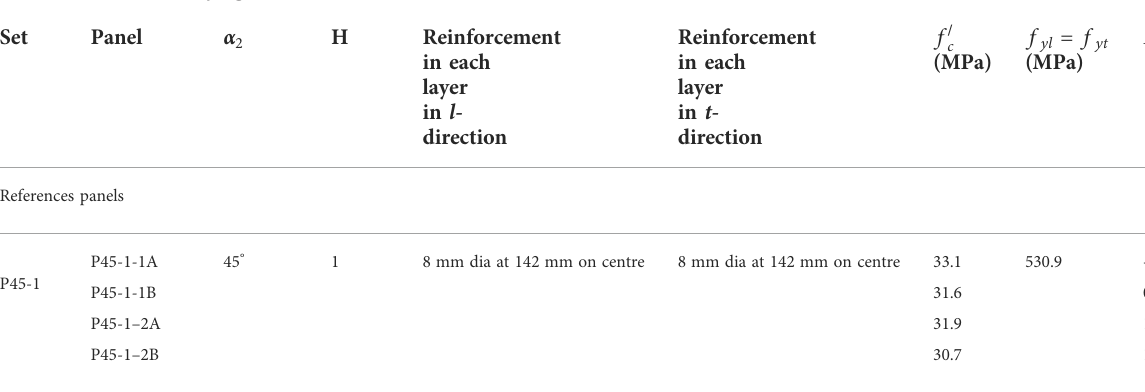
TABLE 1 - Details of test